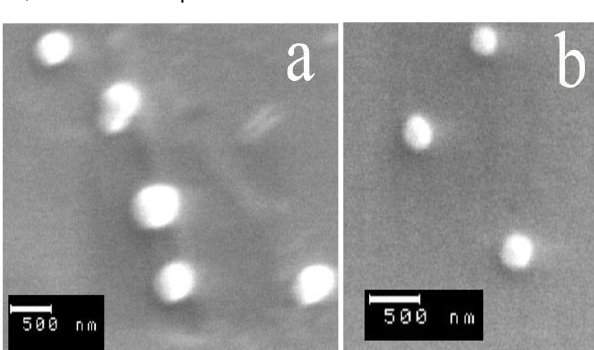
Fig. 1. SEM micrographs nanoparticles cross-linked by CDI (a) and CDI/NHS (b).